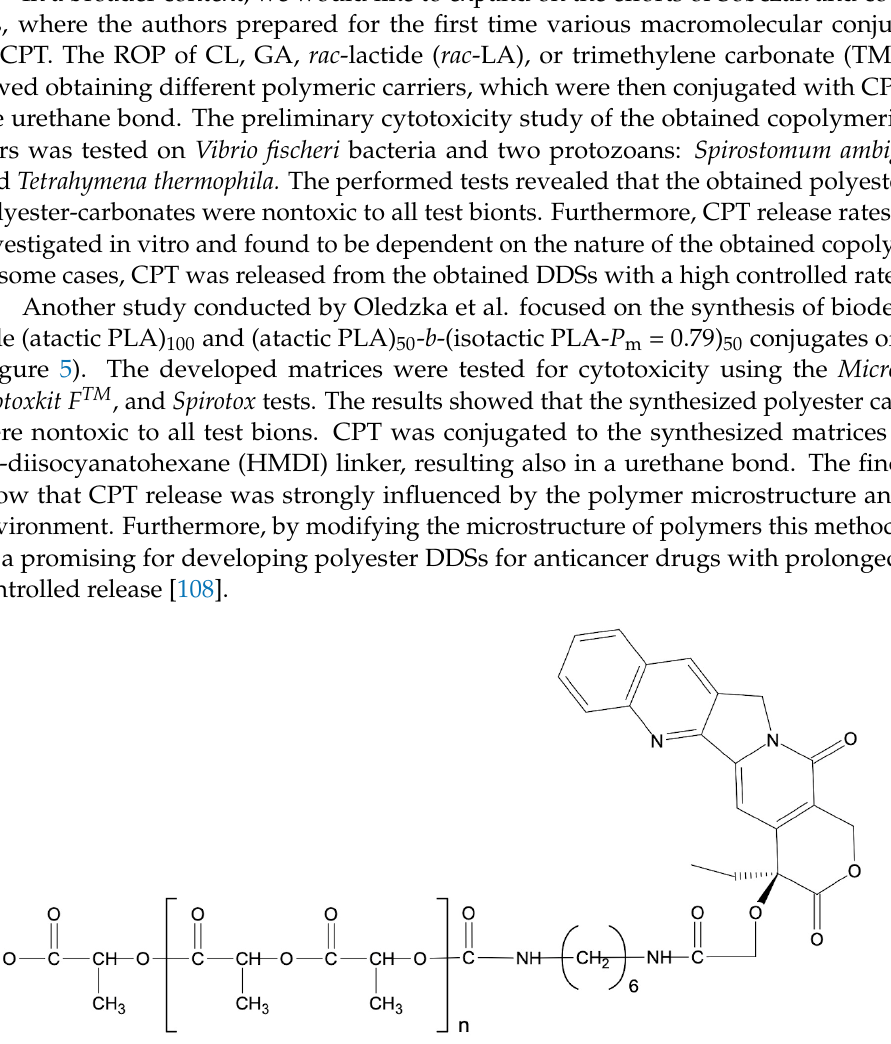
Figure 5. CPT – PLA conjugate obtained by coupling via 1,6-diisocyanatohexane (HMDI). Figure 5. CPT–PLA conjugate obtained by coupling via 1,6-diisocyanatohexane